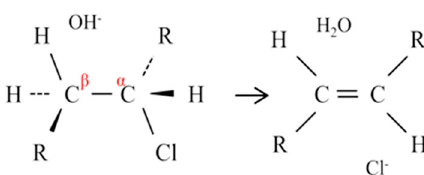
Figure 11. Normalized chlorine intensities obtained using XRF measurements before and after immersion in solutions of different alkali concentrations. ( a ) CMX, ( b ) AMX, ( c ) CMX precursor, and ( d ) AMX